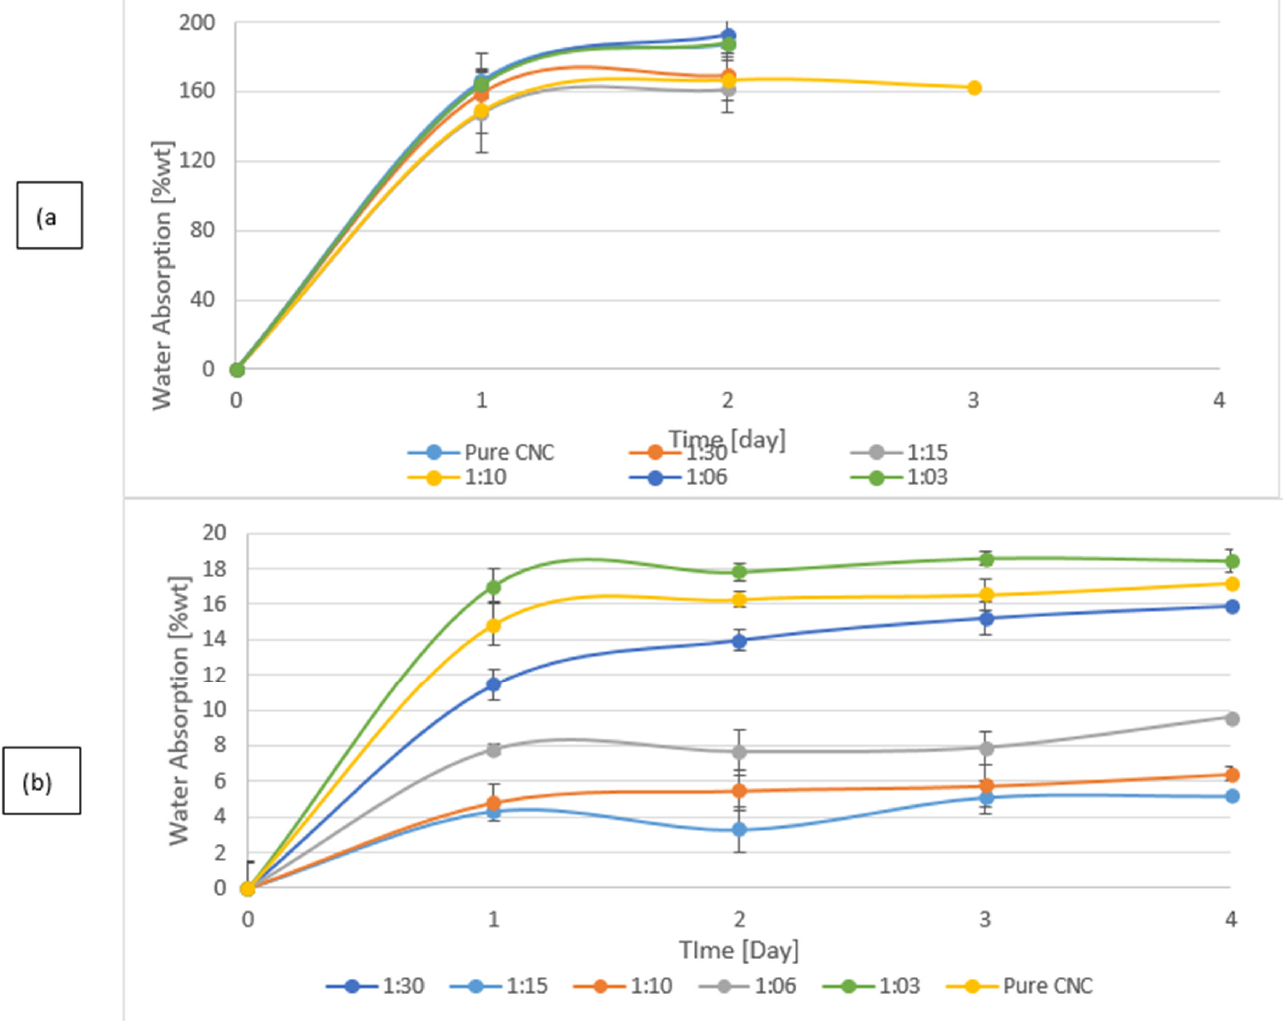
Figure 4. Water absorption over time. ( a ) non-crosslinked CNC and nanocomposite CNC/CZ films and ( b ) crosslinked nanocomposite CNC/CZ films.